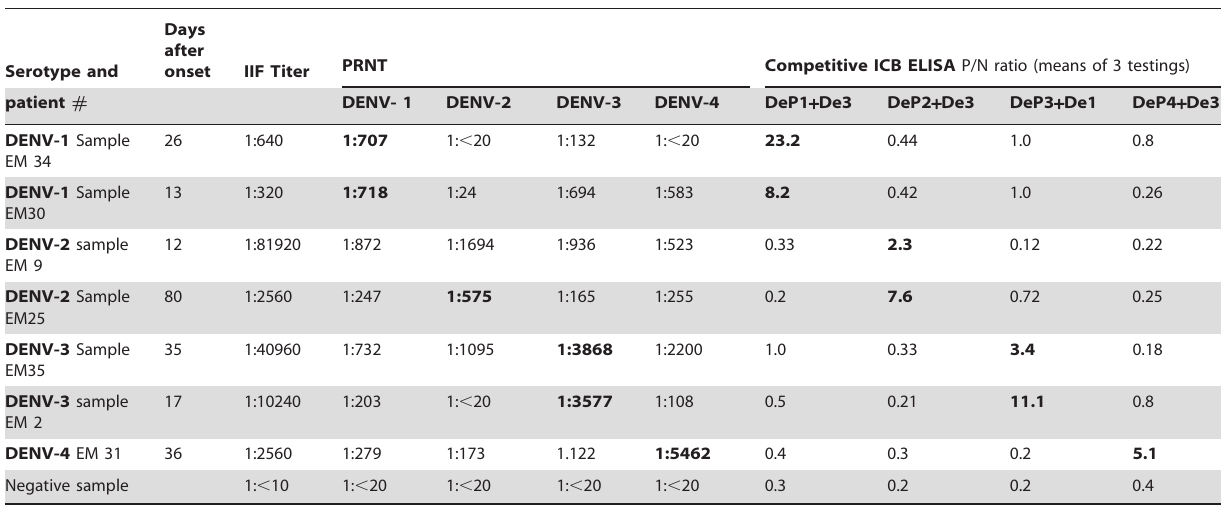
Table 2. Comparison of IIF titers, PRNT titers and P/N ratios obtained with RT-PCR confirmed sera of seven patients with primary DENV infection.